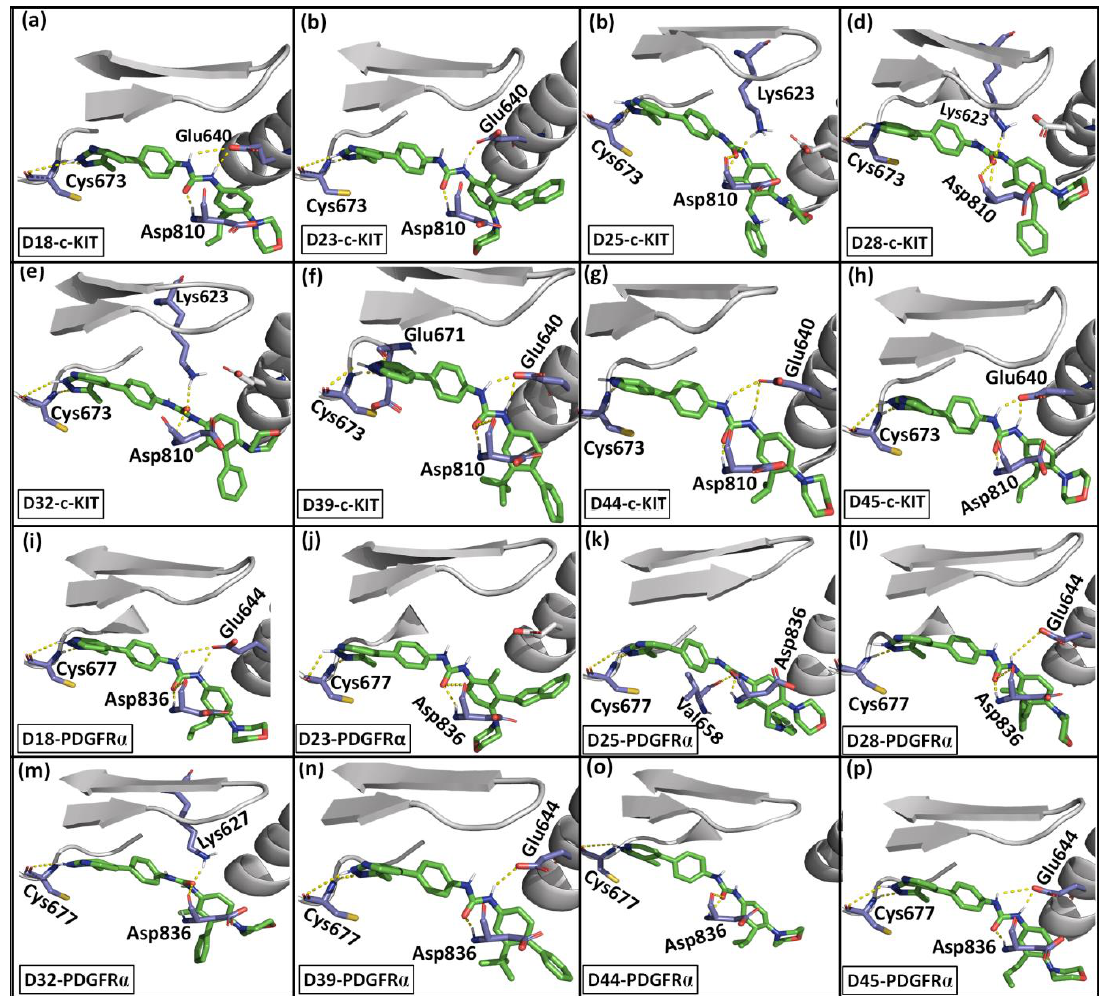
Figure 3. H-bond interactions of the designed compounds with c-KIT and PDGFRα from the MD simulations. Proteins are represented in grey color cartoon representation. Designed compounds are shown in green stick representation. H-bond interactions are represented by yellow dotted lines, and residues forming H-bonds are shown in purple color. ( a ) D18-c-KIT, ( b ) D23-c-KIT, ( c ) D25-c-KIT, ( d ) D28-c-KIT, ( e ) D32-c-KIT, ( f ) D39-c-KIT, ( g ) D44-c-KIT, ( h ) D45-c-KIT, (i) D18-PDGFRα, ( j ) D23-